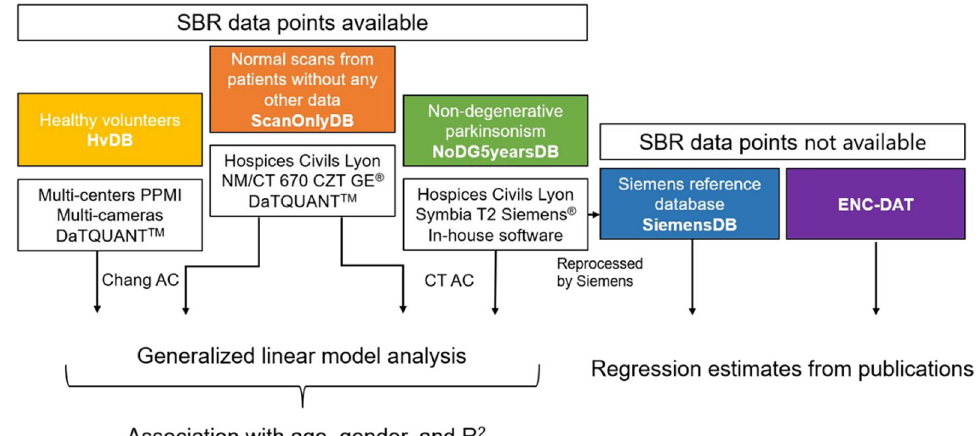
Fig. 1 Schematic presentation of the analysis